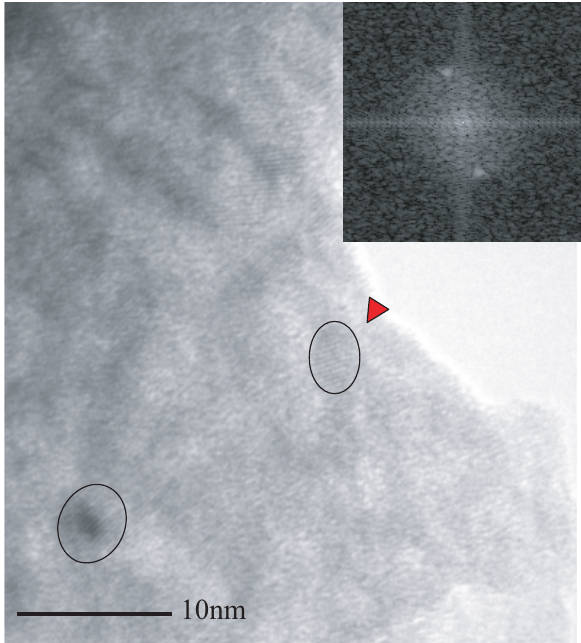
Figure 5. TEM micrographs of sample A. Inset shows a reverse Fourier transformation of a grain with the lattice fringe indicated with a circle.